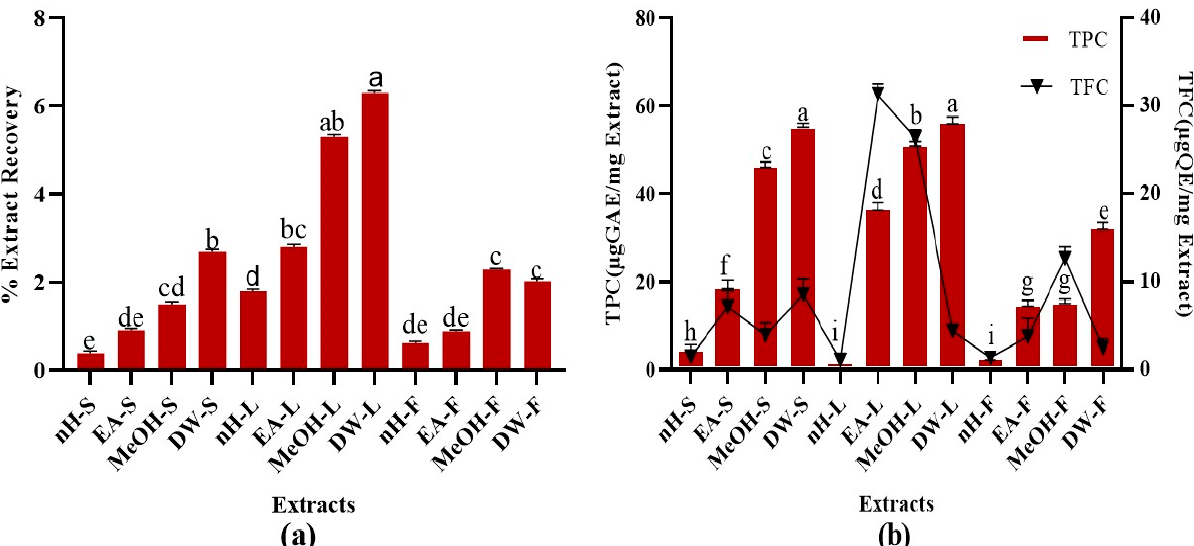
Figure 1. ( a ) Extraction efficiency, ( b ) TPC (Total phenolic content μ g GAE/mg) and TFC (Total flavonoid content μ g QE/mg) of P. roxburghii crude extracts. Assays were conducted in a triplicate manner and the data have been demonstrated as mean ± standard deviation. Significantly different means ( p < 0.05) are represented by different superscripts ( a – i ). nH-S; n-Hexane stem, EA-S;